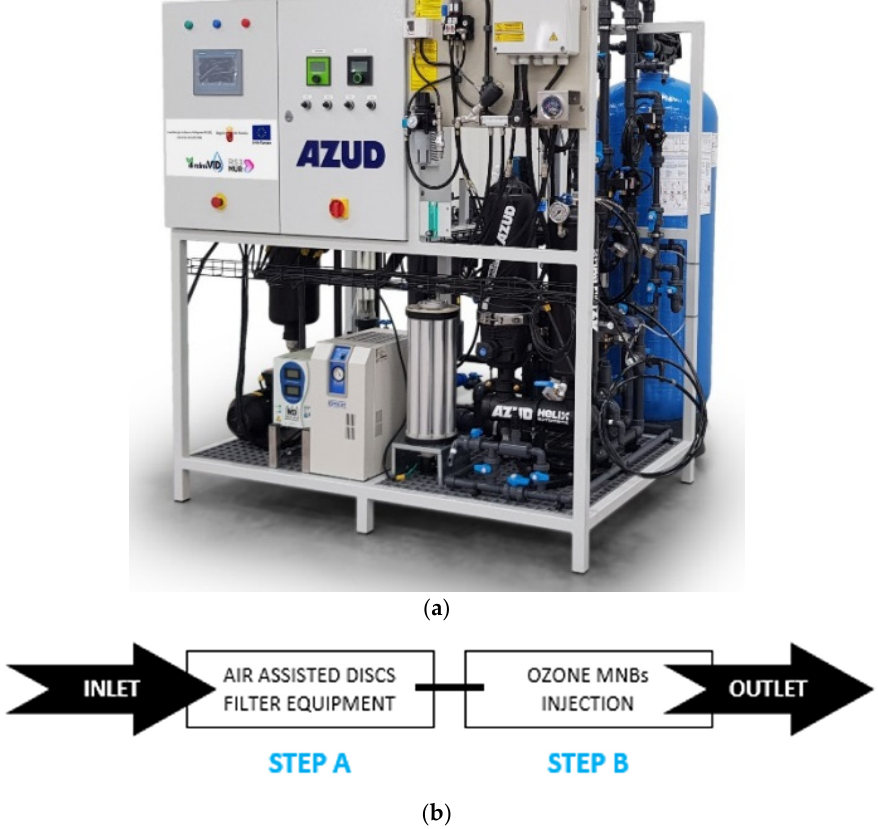
Figure 6. ( a ) O 3 /MNBs system design; ( b ) system treatment line